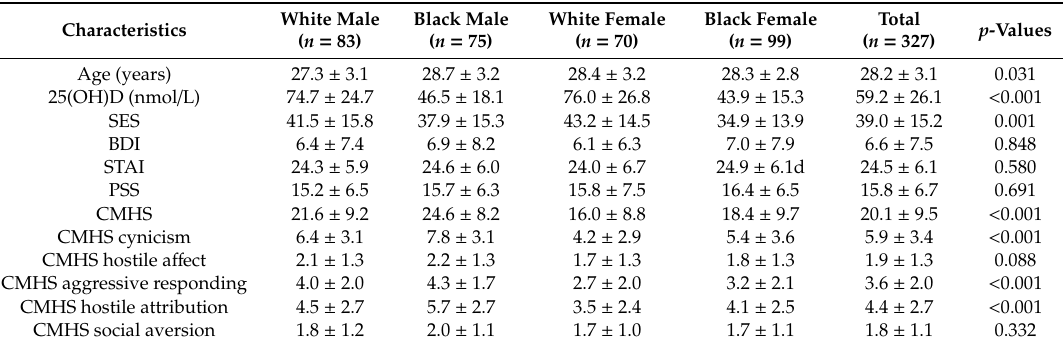
Table 1. General characteristics stratified by gender and